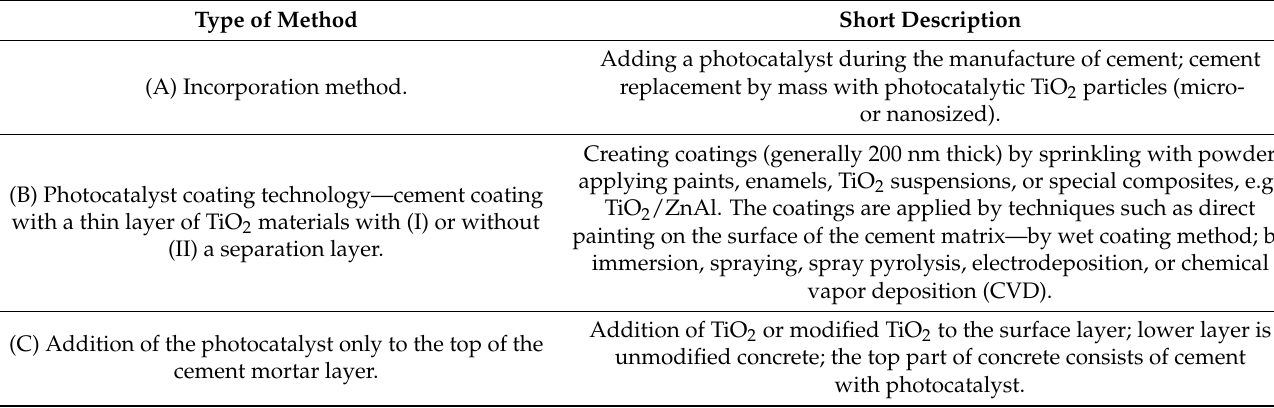
Table 1. Methods of obtaining photoactive